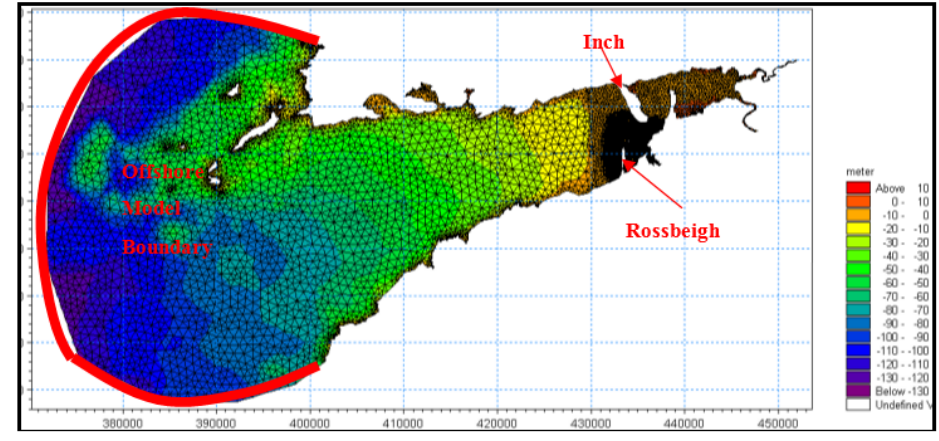
Figure 4. Model Domain.